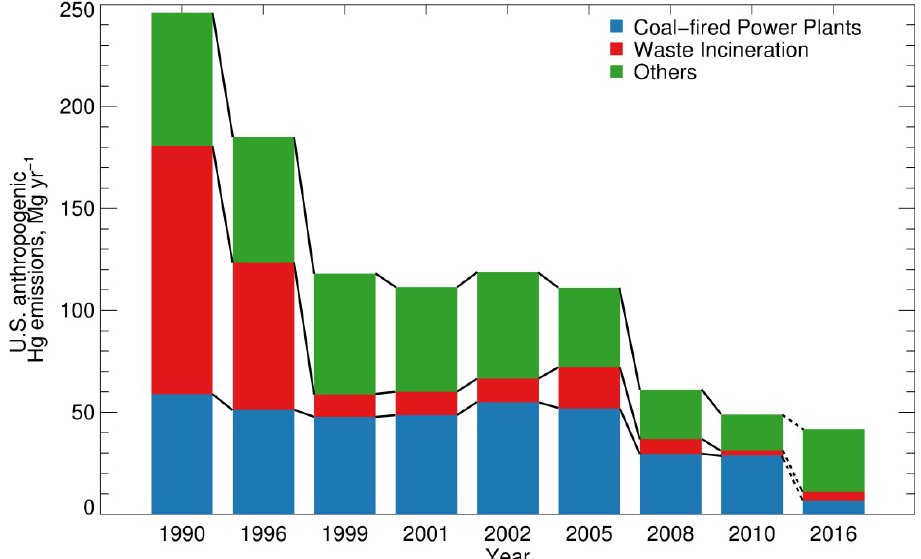
Figure 1. Anthropogenic Hg emissions in the US between 1990 and 2010 and projected emissions for 2016. Hg emissions are lumped into three source categories: coal-fired power plants (CFPPs), waste incineration (including hospital/medical/infectious, municipal, industrial/commercial and hazardous waste incineration and sewage sludge) and others (mainly stone/clay/glass/cement production, chemical production, primary metal production and metal mining). Emissions for 1990, 1999, 2002, 2005 and 2008 are from the National Emission Inventories (NEI) [17]. The 1996 emissions are from the National Toxics Inventories (NTI) [16]. The data for 2001 is from US EPA [23]. The CFPP emission for 2010 is based on Information Collection Request (ICR) by the EPA [20]. For 2010, non-CFPP emissions are estimated based on Toxic Release Inventories (TRI) for 2005 and 2010